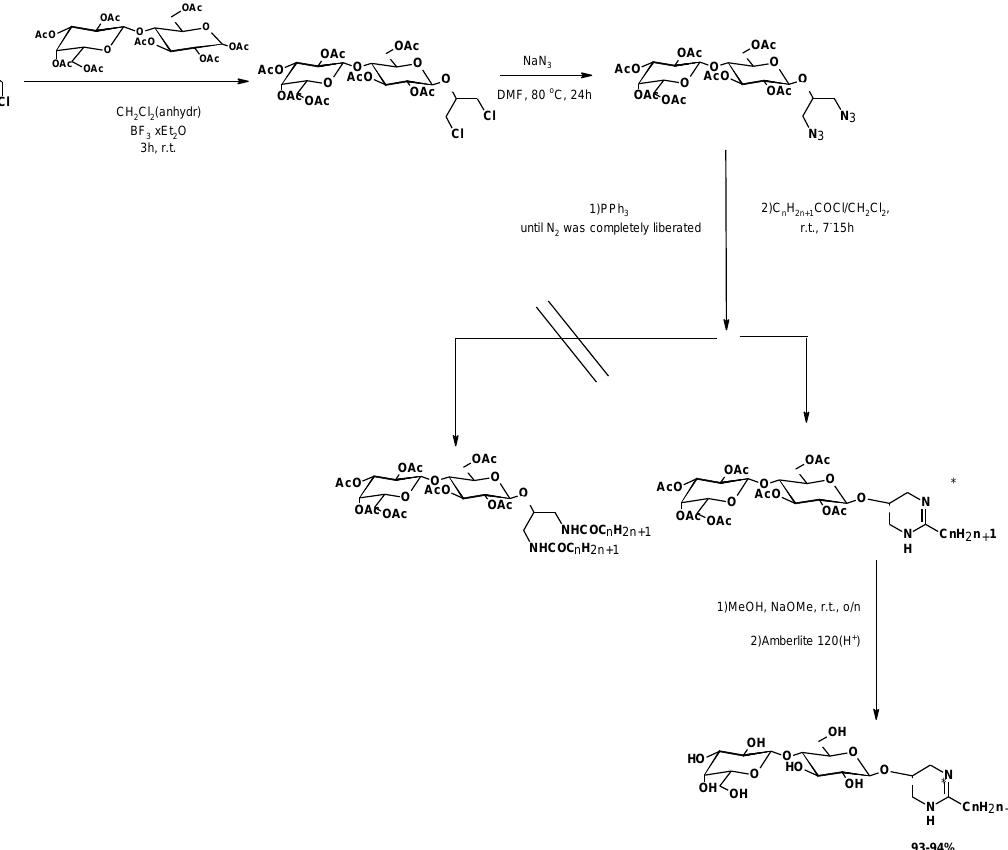
Figure 13. Synthesis of 1,2- cis -alkyl tetra- O -acetyl glycosides, using 1,3-DCH.